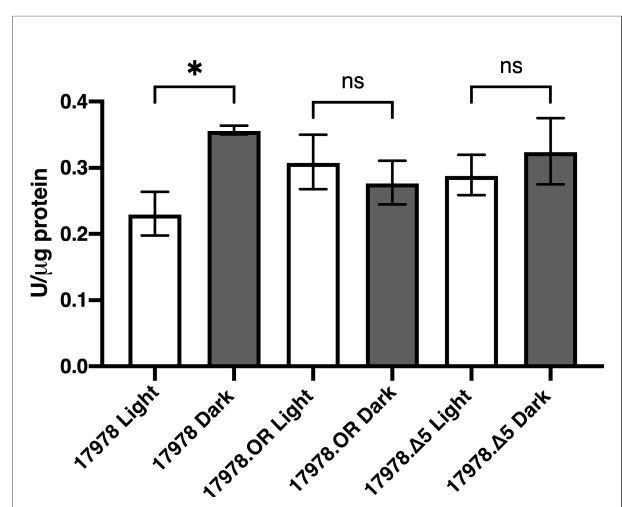
FIGURE 6 | The role of BlsA in the regulation of superoxide dismutase activity. SOD levels of the 17978 wildtype and mutant strains were measured using culture samples representing equal numbers of bacteria that had been grown in SB under blue light or in darkness with shaking to exponential phase at 24°C. SOD activity was measured and normalized to total protein concentration for 2-3 independent biological replicates in technical triplicate. Error bars represent the standard deviations of the data sets. Horizontal bars with symbols indicate results of ordinary one- way ANOVA with Sidak ’ s multiple comparisons post-hoc test (* P ≤ 0.05; ns, not signi fi cantly